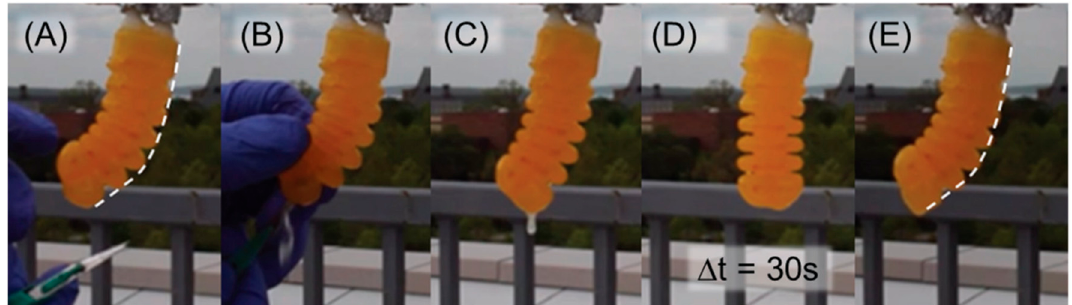
Figure 10. Synthetic antagonistic muscle actuator printed from the 2.5% 186 resin: ( A ) pressurized with low-viscosity prepolymer resin; ( B ) pierced by a scalpel; ( C ) pressurized fluid draining; ( D ) autonomous self-healing via ambient sunlight in the relaxed state for 30 s ( E ) returning to its original actuated state (dashed line) with repressurization. Reproduced from [224] with permission from the Royal Society of Chemistry.